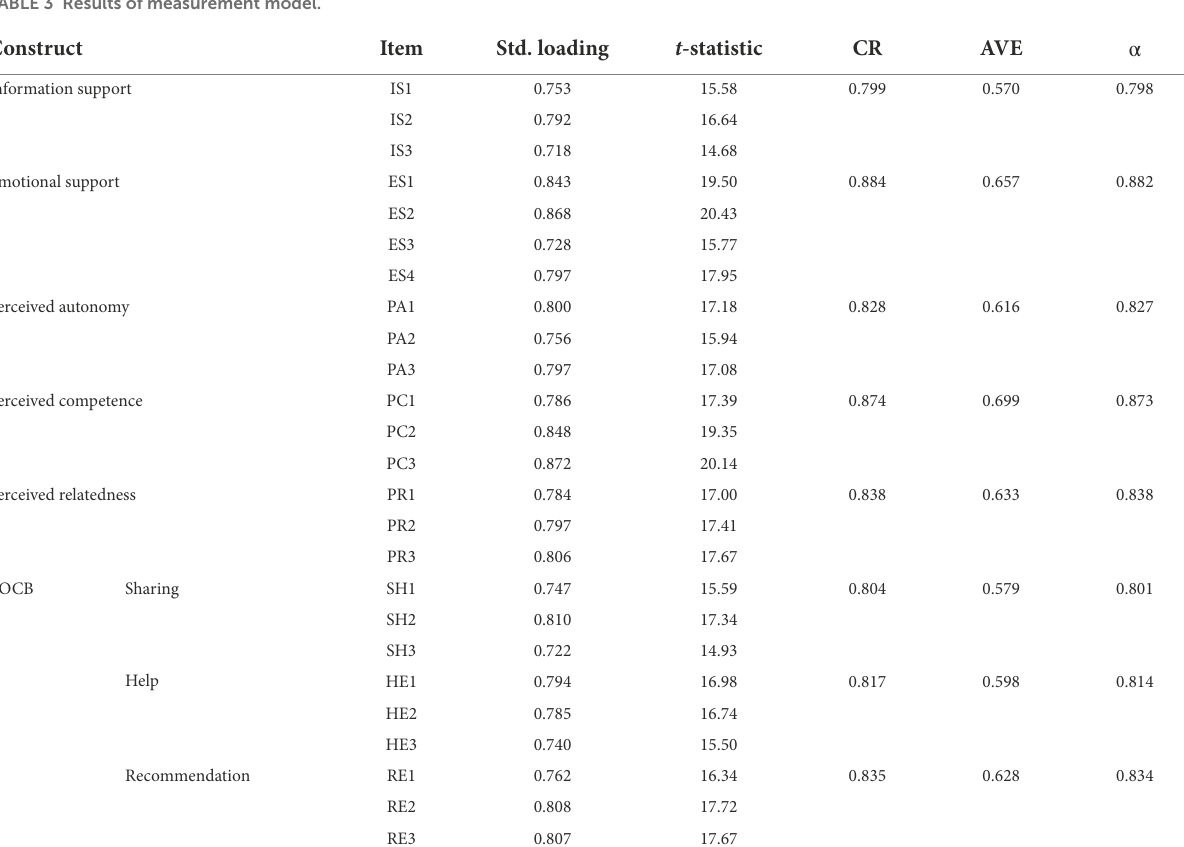
TABLE 3 Results of measurement model.